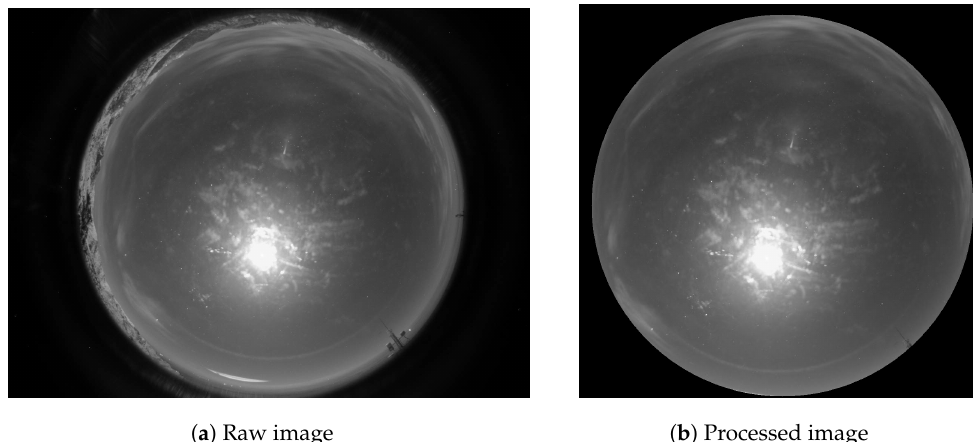
Figure 2. Preparation of nighttime image. ( a ) Raw image of the local sky, with non-relevant sections and a circular projection of the sky. ( b ) Image has been cropped and masked (buildings and ridges).